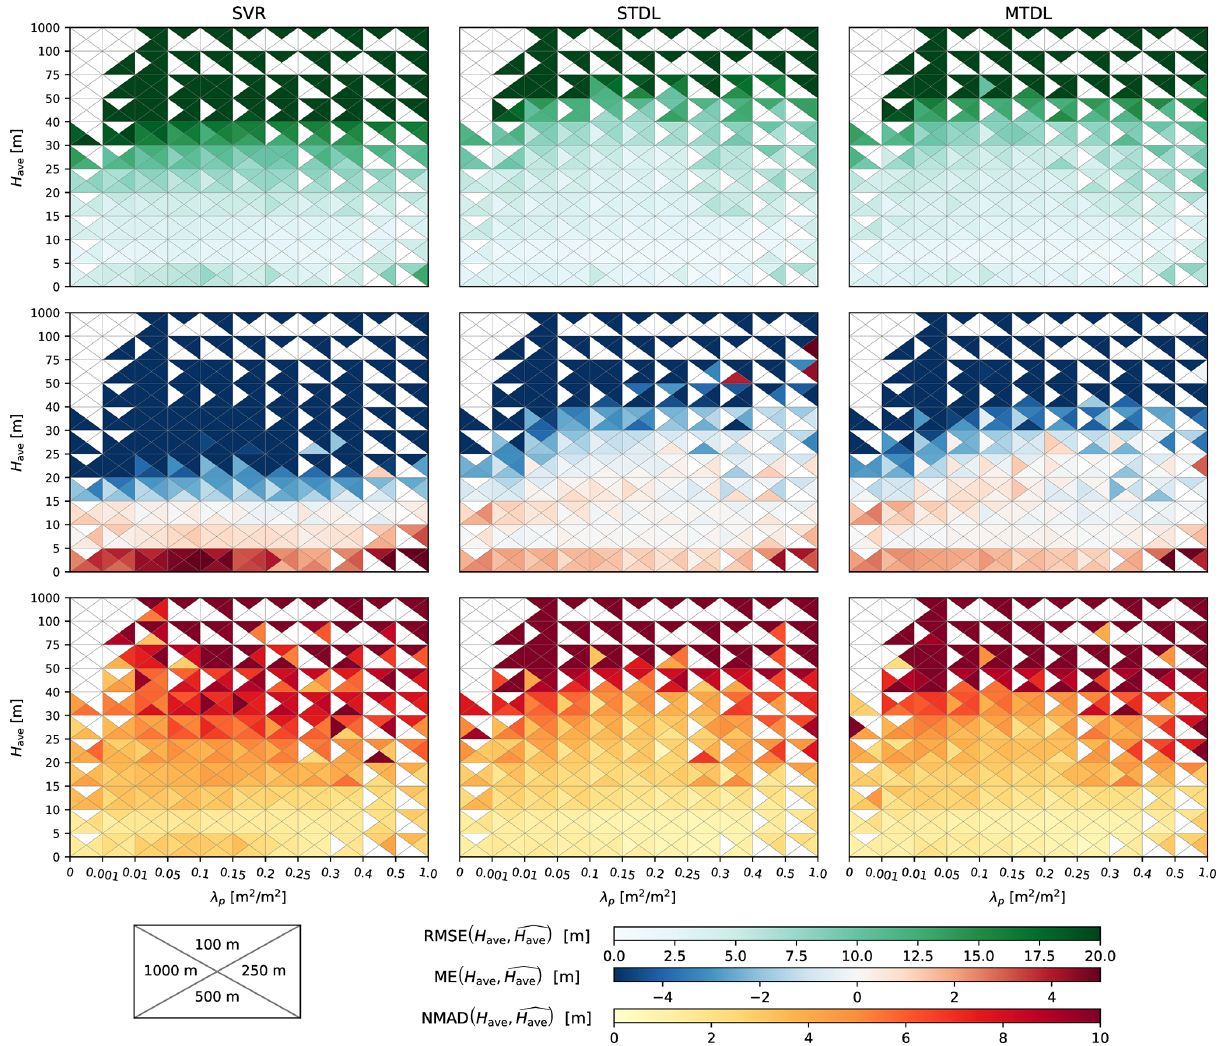
Figure 6. Error metrics of building height prediction in different target domains. Only results from SVR are presented since it achieves the best performance among the three ML